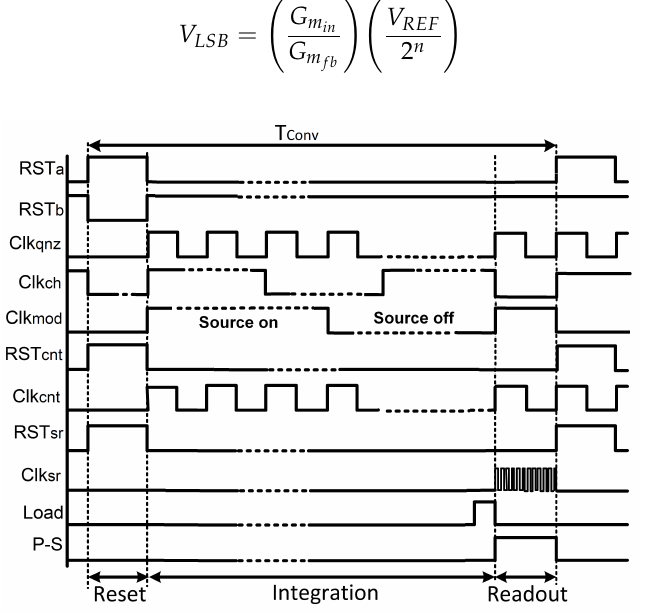
Figure 8. Timing diagram of the THz readout